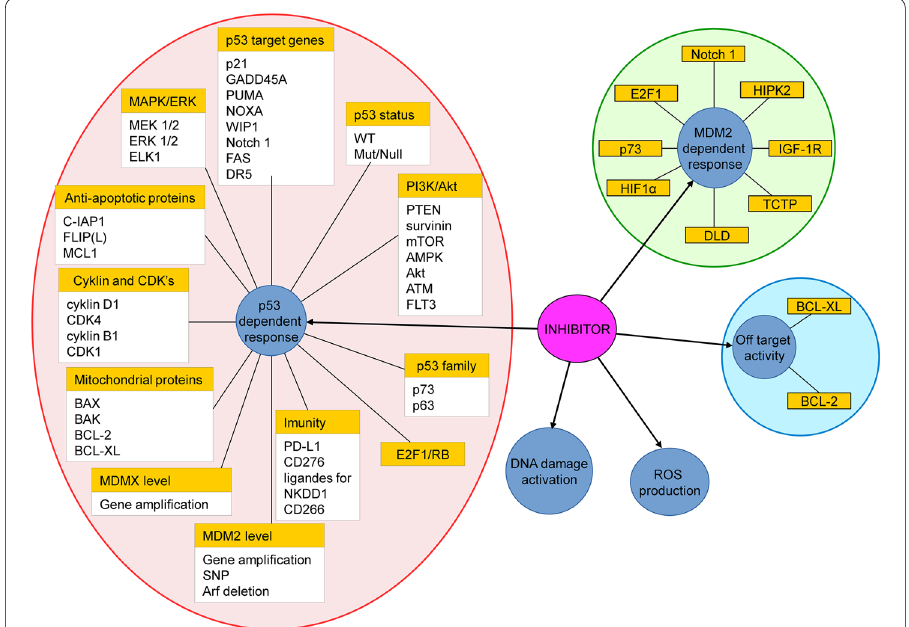
Fig. 5 Determinants of response to MDM2 inhibitors. The overall representation of factors determining sensitivity to MDM2 inhibitors divided into MDM2‑dependent determinants, p53‑dependent determinants, off‑targets and other determinants. The determinants are divided into related groups of proteins. All of these factors were reported in the literature to affect the sensitivity to MDM2 inhibitors designed to disrupt the p53‑MDM2 interaction